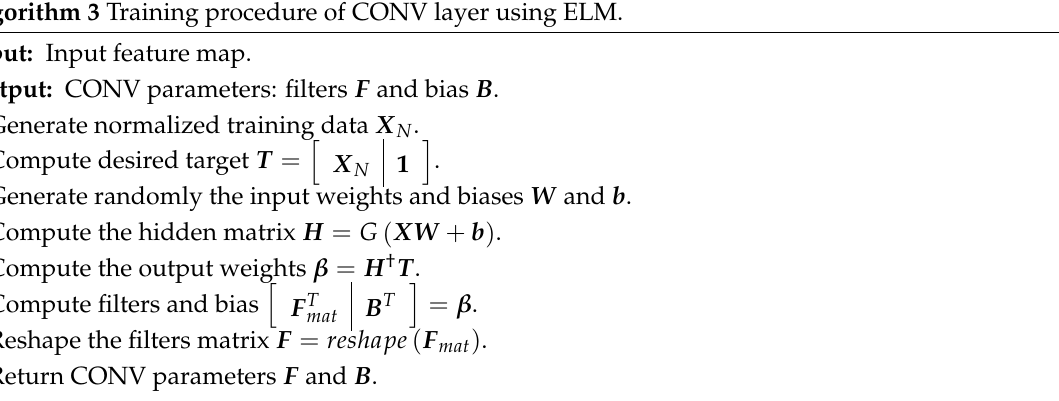
Algorithm 3 Training procedure of CONV layer using